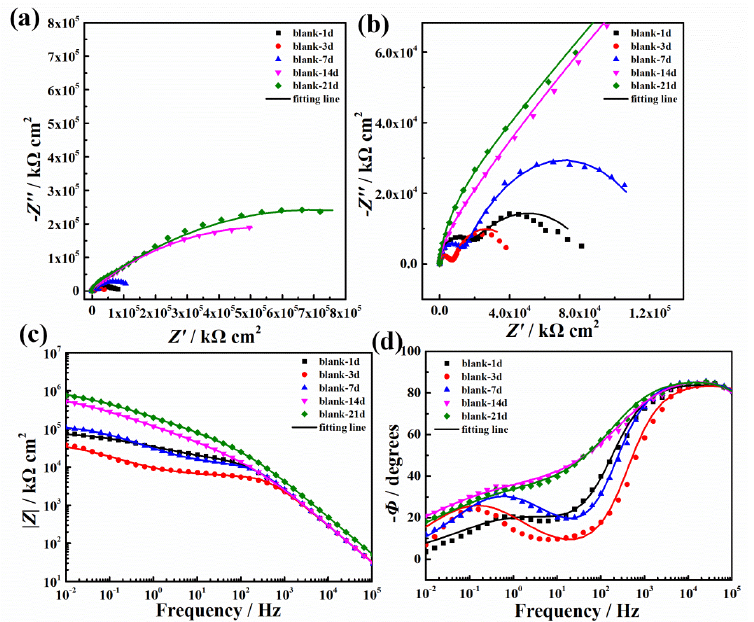
Figure 12 c, the impedance of the sample at 1 – 7 d at low frequency (0.01 Hz) was around 1 × 10 5 kΩ cm 2 , while this value increased to more than 5 × 10 5 kΩ cm 2 after immersion for 14 d and 21 d. It can be seen from Figure 12d that two phase angle peaks appeared in the Bode plots, therefore, an equivalent circuit including two-time constants in Figure 17a was used to fit the EIS data of this sample, where R s is the solution resistance, R c and R ct present the coating resistance and the charge transfer resistance, respectively. CPE c and CPE dl stand for the constant phase elements of the coating and the double layer [8,43].